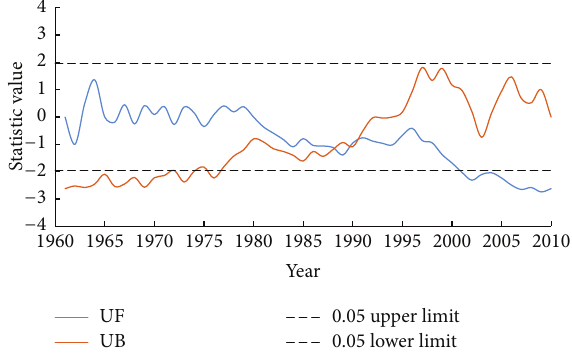
Figure 6: The result of M-K